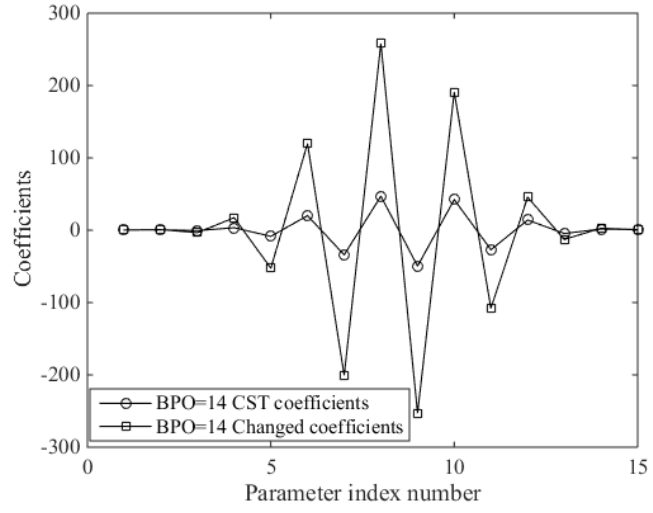
Figure 10. Comparison of the parameterization matrix using CST.